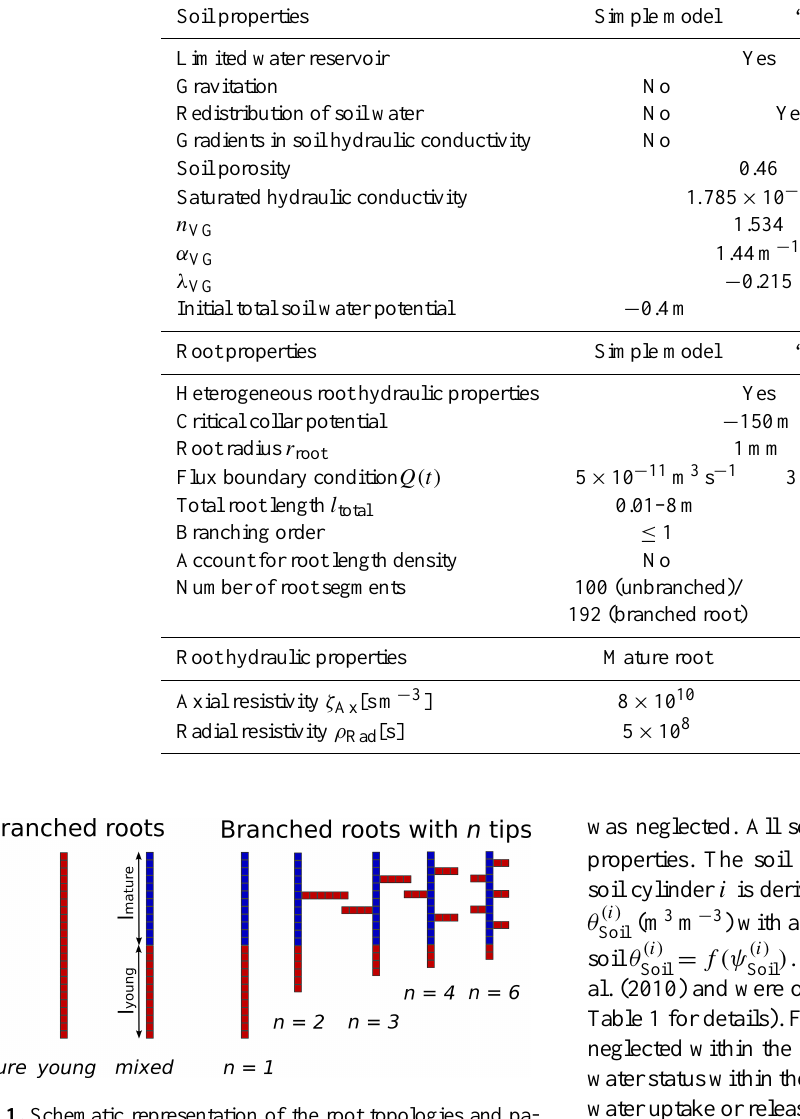
Figure 1. Schematic representation of the root topologies and pa- rameters that were investigated with the simple root water uptake model. Young ( l young ) and mature root length ( l mature ) are varied independently both in unbranched and branched root structures, re- sulting in varying total length ( l total ) and mature root proportion ( p mature ) . In all heterogeneous cases mature roots constitute the basal part of the root. Within branched roots, total young root length is evenly divided into n parts, which are attached to the central ma- ture root at equal distances. A mixed root strand can equivalently be regarded as a branched root with n = 1. Gravity and soil water flow are neglected in the simple